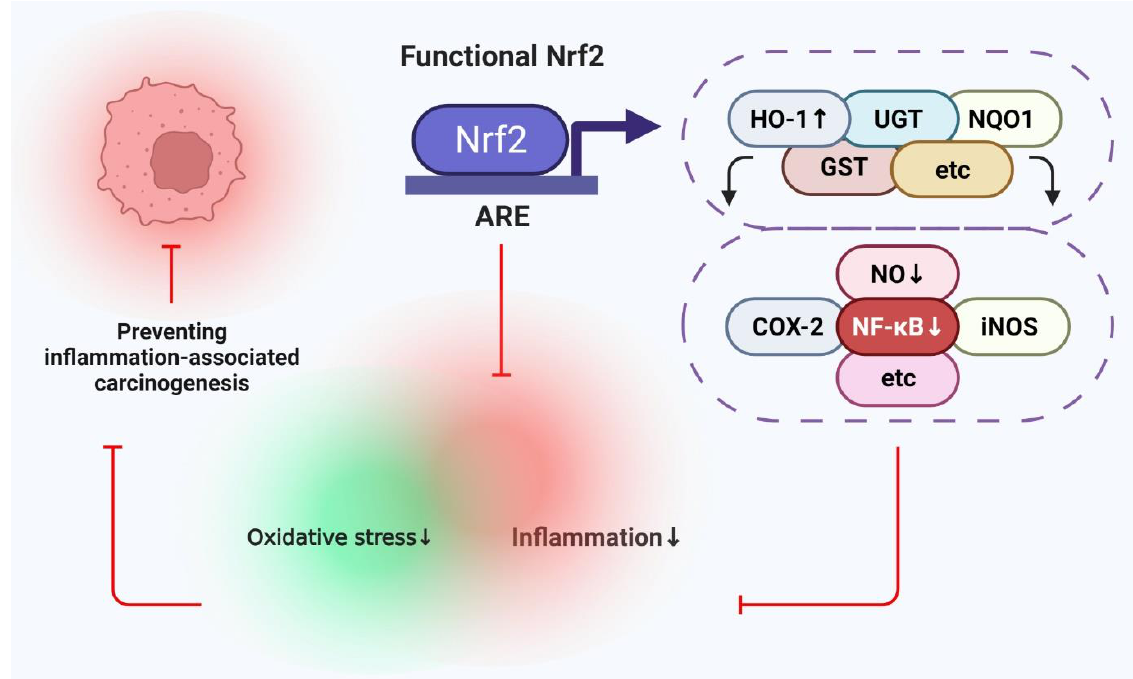
Figure 3. Correlation between Nrf2 and NF- κ B in counteracting inflammation-associated cancer. Activation of Nrf2 after binding to antioxidant response element (ARE) leads to the production of antioxidant enzymes (HO-1, UGT, NQO1, GST), which can lead to suppression of NF- κ B. This leads to indirect inhibition of NF- κ B targets enzymes such as NO, COX-2, and iNOS. The overall effect is a reduction in oxidative stress and inflammation by the Nrf2 pathway, which can serve as a valuable target in preventing inflammation-associated cancer.